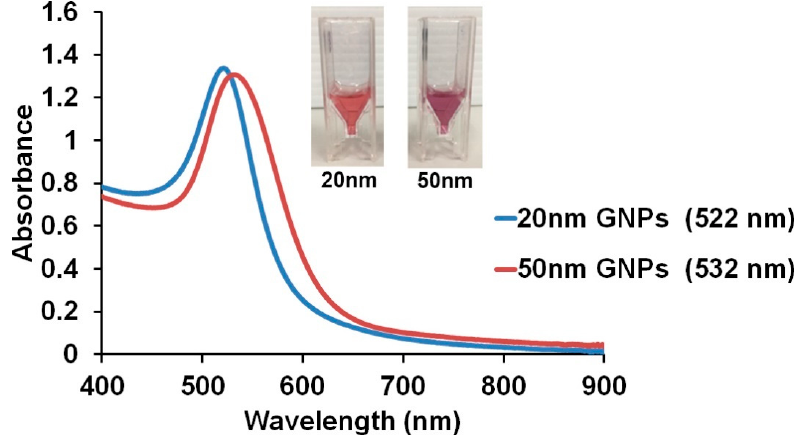
Figure 3. Light absorption spectra of the 20 nm and 50 nm GNPs.